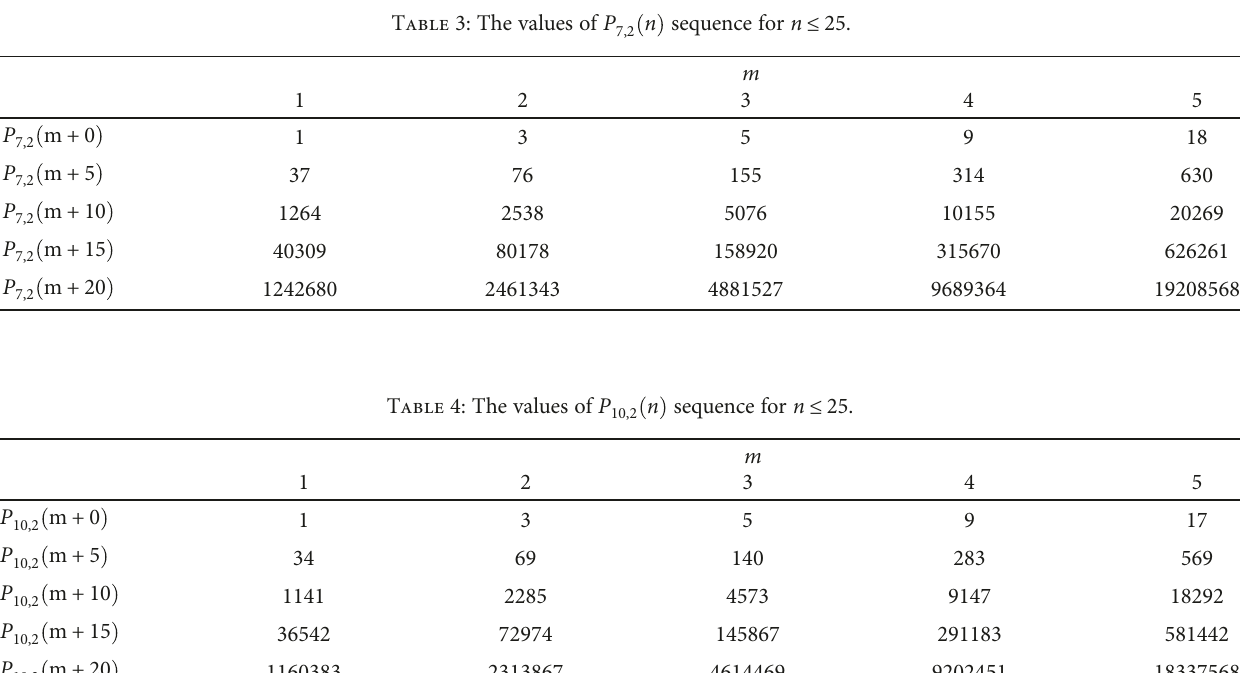
Table 3: The values of P